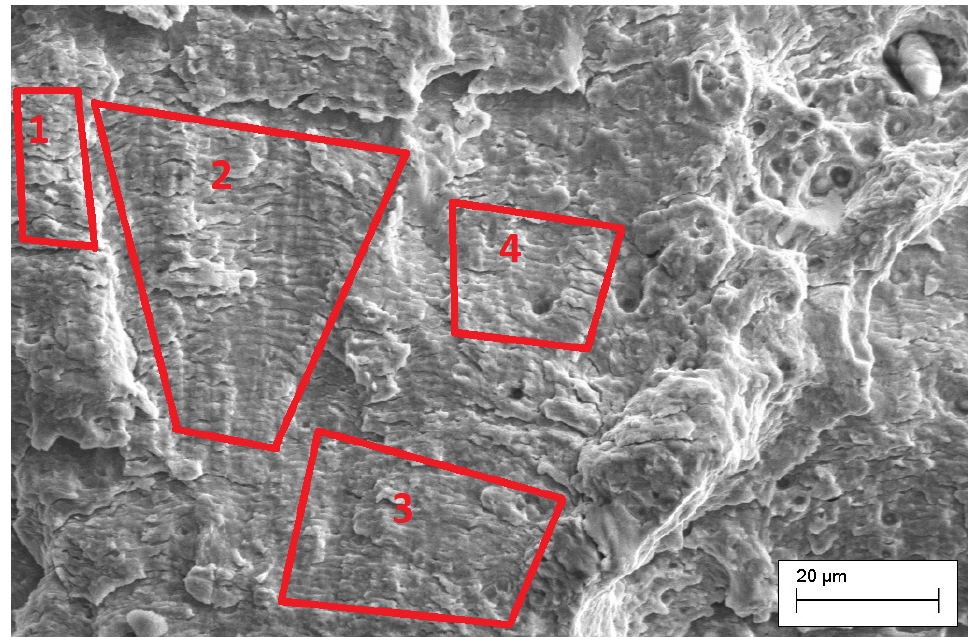
Figure 1. Typical fractographic image of the fatigue fracture surface of 34KhN3M steel in the initial state with small fatigue striations located across narrow strips elongated in the FCG direction. Four fragments selected for further analysis and demonstration of the possibilities of proposed approach are highlighted in the fractogram.